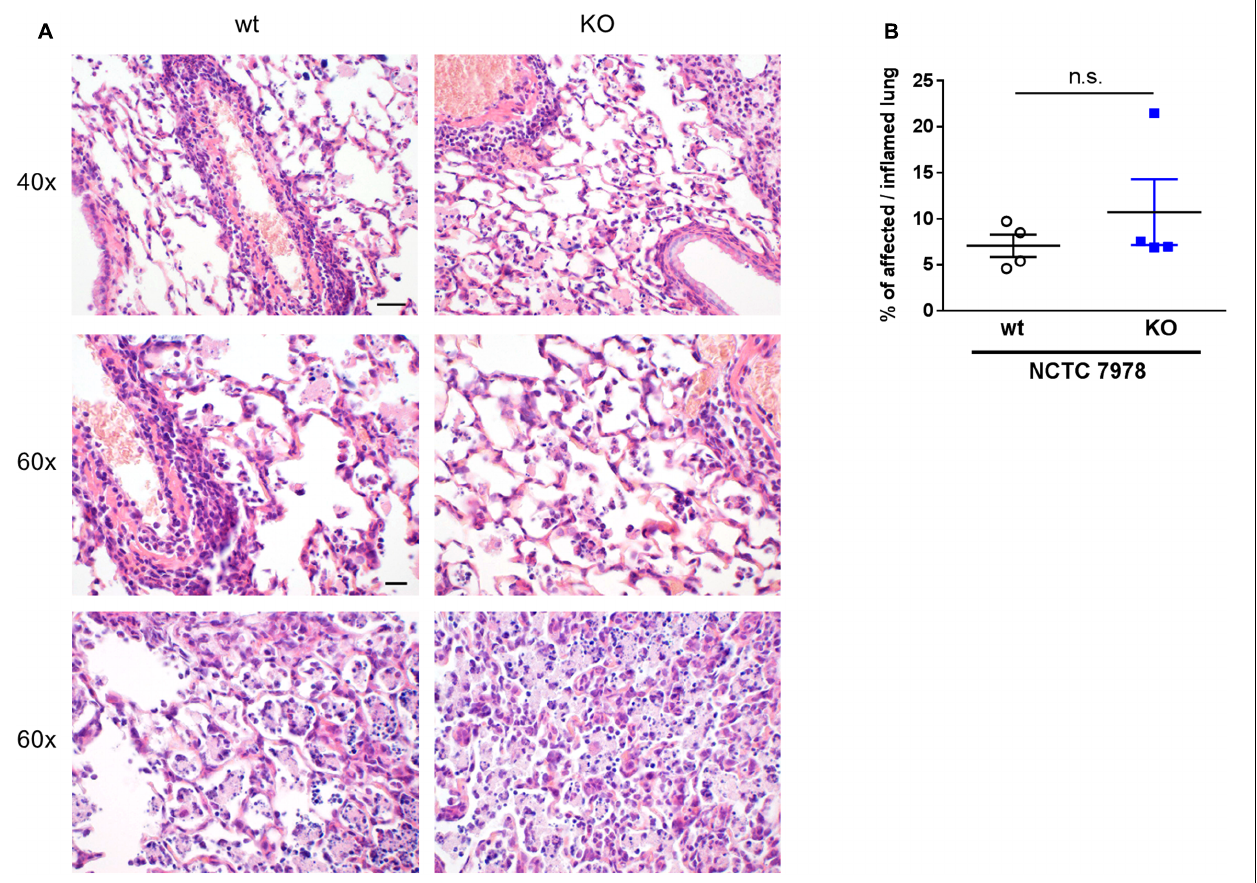
FIGURE 5 | Histology and digital image analysis of infected wt and PGLYRP3KO mouse lungs. Lungs were harvested 48 h post infection with 10 5 CFUs S. pneumoniae (NCTC 7978) per mouse, fixed in formalin and embedded in paraffin. Two micrometer sections were prepared and stained with hematoxylin and eosin (A) for histopathological analysis. Representative images for wt and PGLYRP3KO are shown ( n = 4 per group). Bar (40 × ) 100 µ m, Bar (60 × ) 20 µ m. Quantitative image analysis on digitalized whole lung sections was performed. Genie pattern recognition algorithm was adapted and the percentages of affected/inflamed lung areas were assessed (B) . Four animals per group (mean ± SEM); Mann–Whitney U test was used for statistics: ns, not